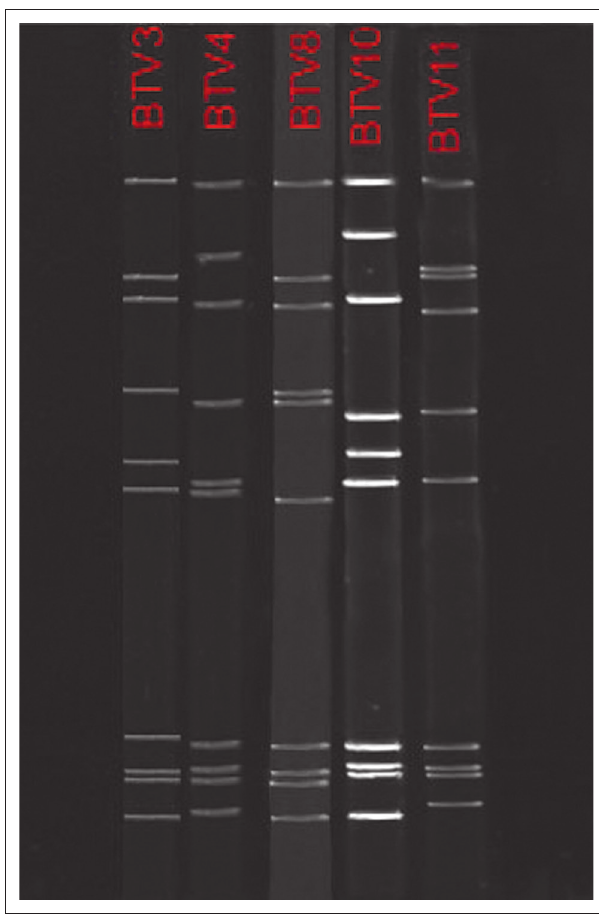
FIGURE 2: Electrophoretic profiles of the parental viruses using polyacrylamide gel electrophoresis. All 10 segments are visible and each serotype has a unique